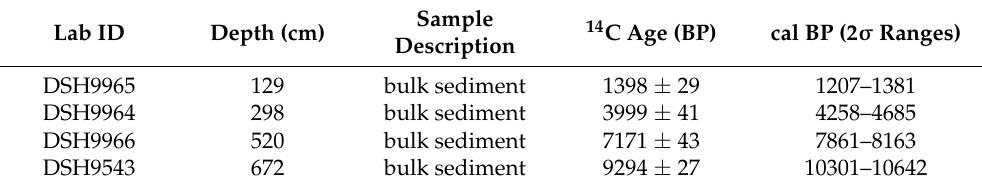
Table 1. List of radiocarbon dates conducted on core LS presented with depth (cm). Conventional dates were calibrated through IntCal20 calibration curve [19].